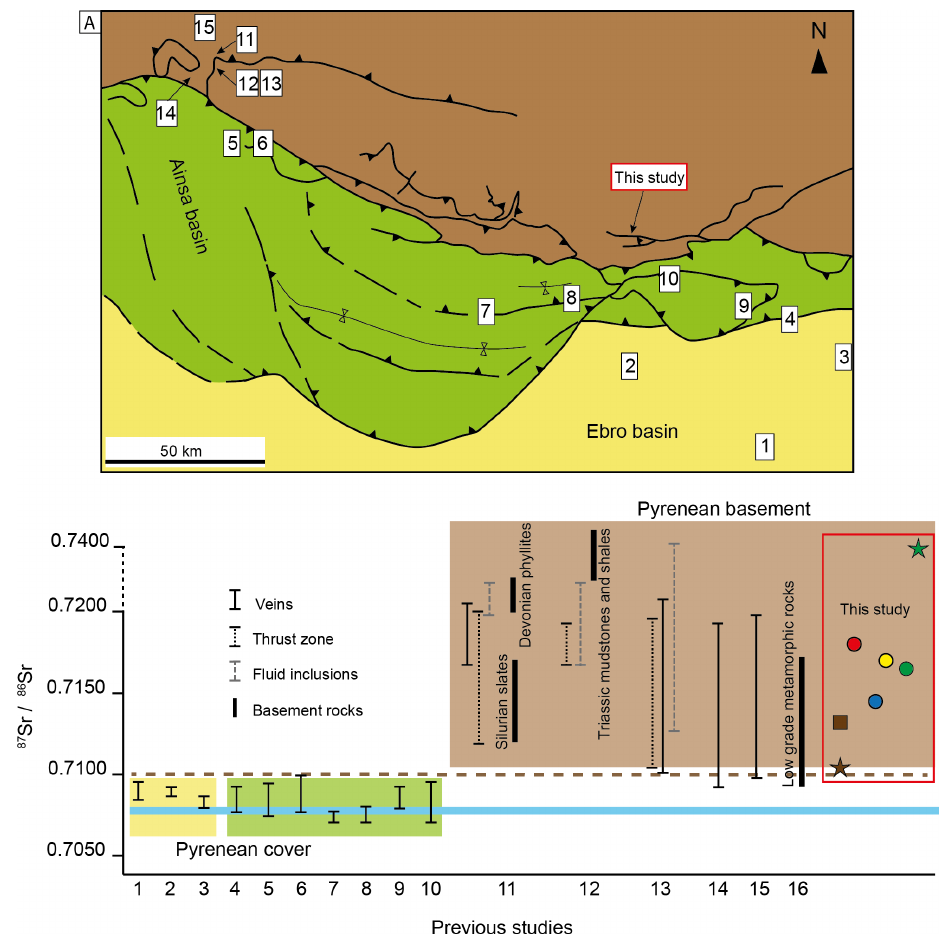
Figure 11. Simplified geological map of the south-central Pyrenees showing the location of structures where 87 Sr / 86 Sr analyses have been carried out. Below are 87 Sr / 86 Sr ratios from this study compared to results from other structures involving either cover units (1–10) or basement rocks (11–16). The thick blue line refers to the 87 Sr / 86 Sr range of Phanerozoic seawater, and the dashed brown line represents the 87 Sr / 86 Sr limit value between basement and cover structures. (1) El Guix anticline (Travé et al., 2000), (2) Puig Reig anticline (Cruset et al., 2016), (3) L’Escala thrust (Cruset et al., 2018), (4) Vallfogona thrust (Cruset et al., 2018), (5) Ainsa basin (Travé et al., 1997),